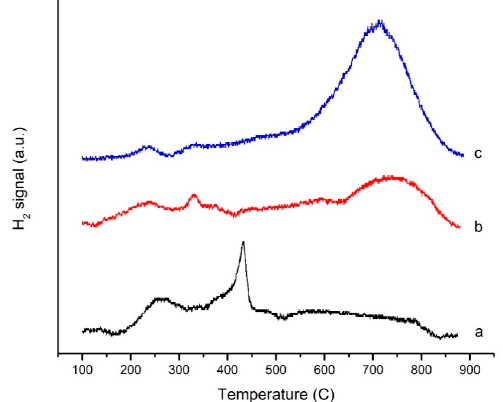
Figure 2. Temperature programmed reduction (TPR) profile of ( a ) 10Ni / AC, ( b ) NiMgO / AC, and ( c ) Ni / MgO /